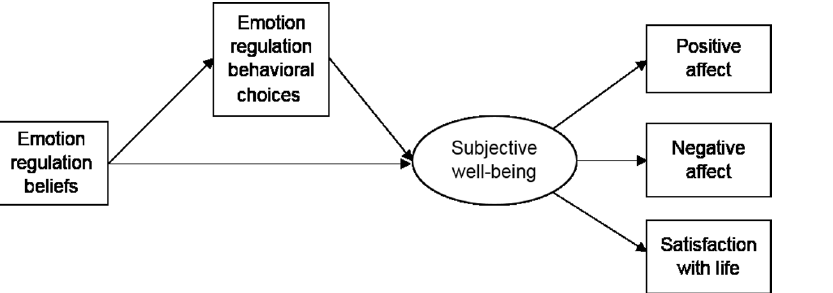
Figure 1. Hypothesized model of the relation between emotion regulation beliefs, emotion regulation behavioral choices, and subjective